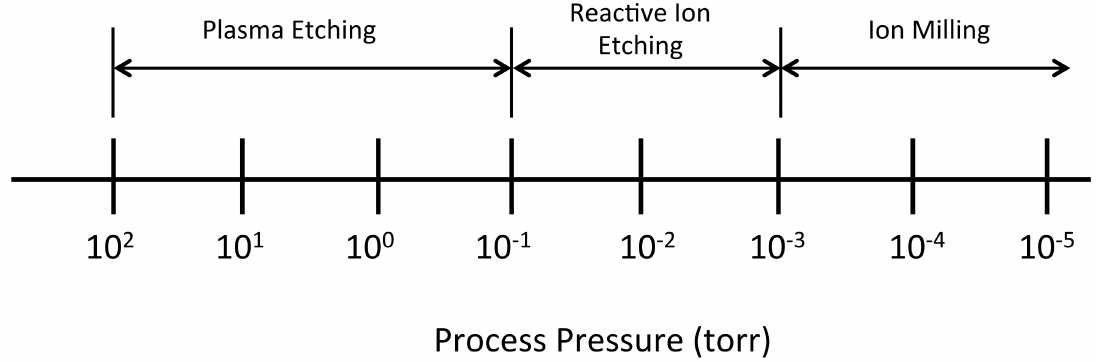
Figure 1. Spectrum of dry etching processes and their relationship to the process pressure